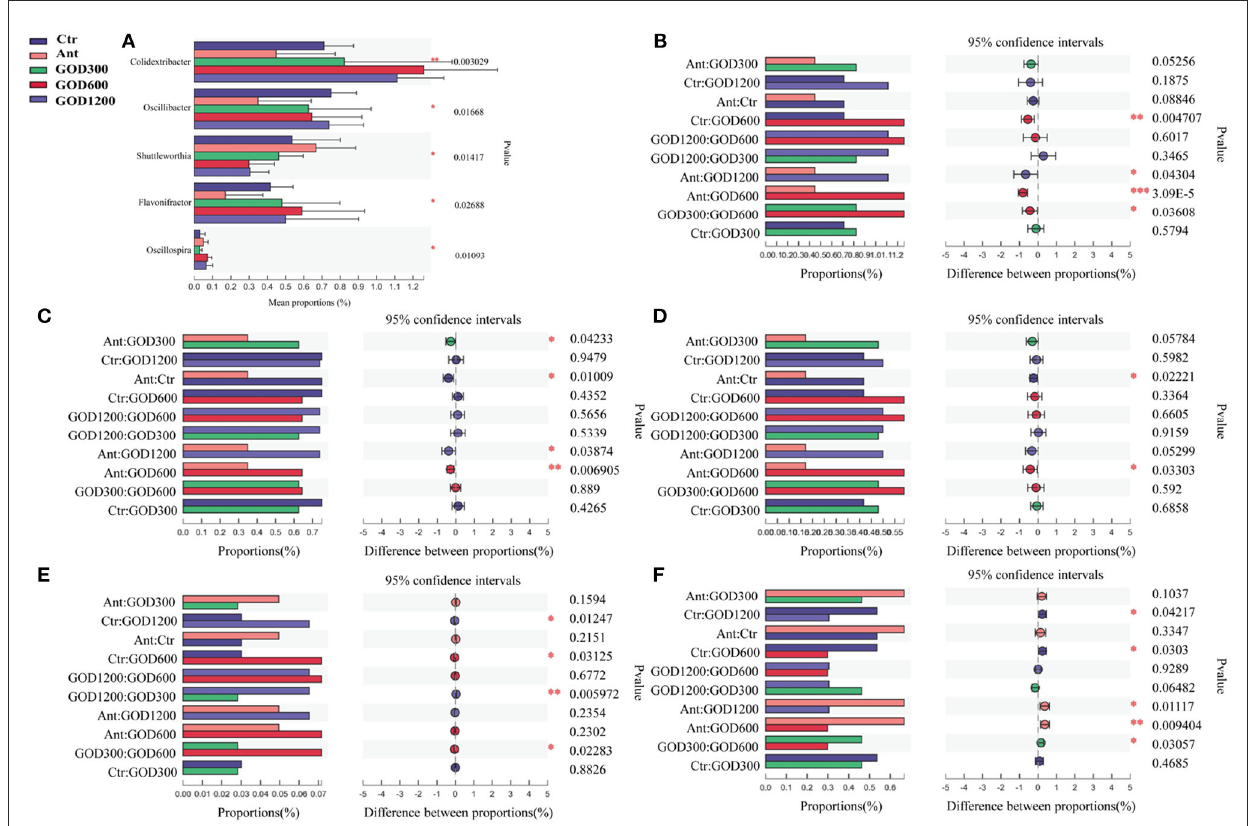
FIGURE4 Five significantly differential bacteria ( P < 0.05) of the cecal microbiota under different concentrations of GOD and the antibiotic-supplied diet on day 42 of the broilers at the genus level. ( n = 6, P < 0.05) among multiple comparisons (A) and pairwise comparisons for each one (B–F) . (B) for Colidextribacter , (C) for Oscillibacter , (D) for Flavonifractor , (E) for Oscillospira , and (F) for Shuttleworthia . Ctr, negative control fed with the basal diets; Ant, positive control fed with the basal diets added 50 mg/kg aureomycin; GOD300, GOD600, and GOD1200, the basal diets supplied with 300, 600, and 1,200 U/kg glucose oxidase, respectively. Ctr, negative control group fed with the basal diets; Ant, positive control group fed with the basal diets added 50 mg/kg